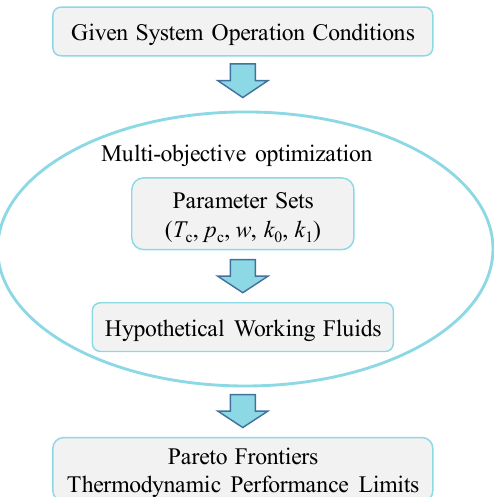
Figure 13. Schematic diagram of EOS method in ORC optimization.